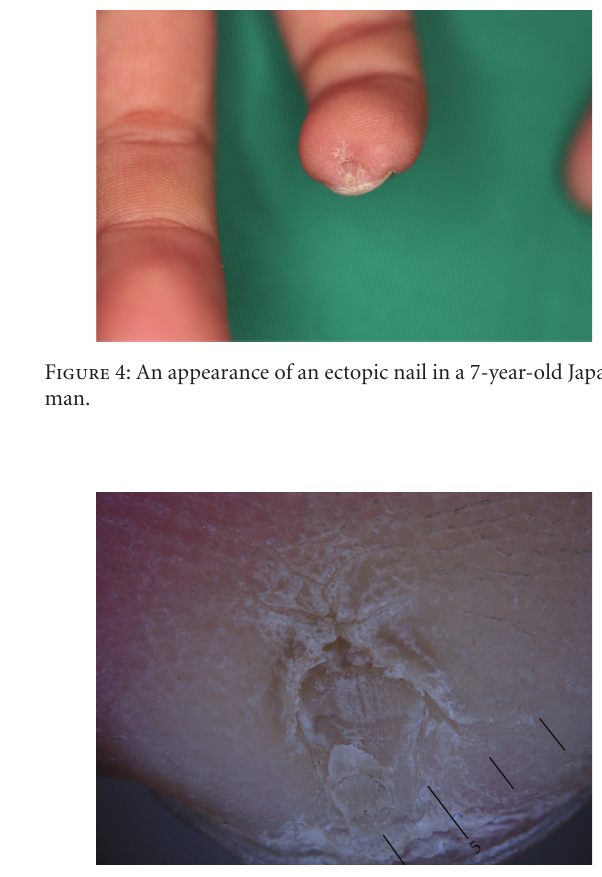
Figure 5: A dermoscopic figure of the ectopic nail. Most of the nail plate was covered by